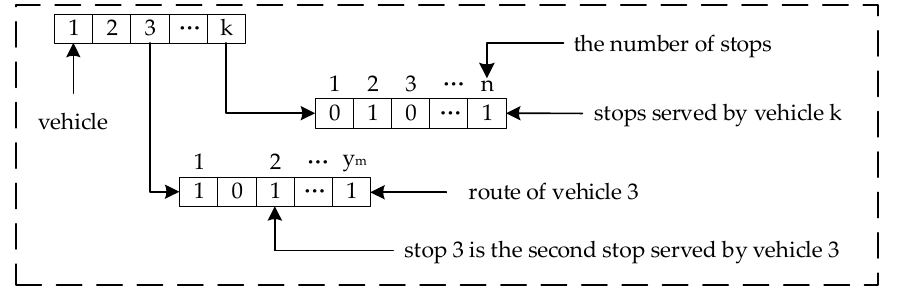
Figure 1. Schematic plot of antibody coding.